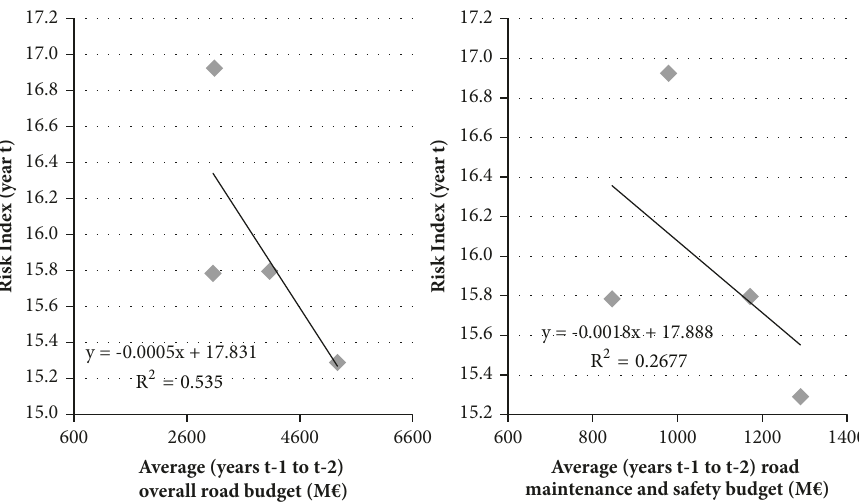
Figure 5: Relationship between Risk Index and Average Values of Road Budgets (2 previous years).